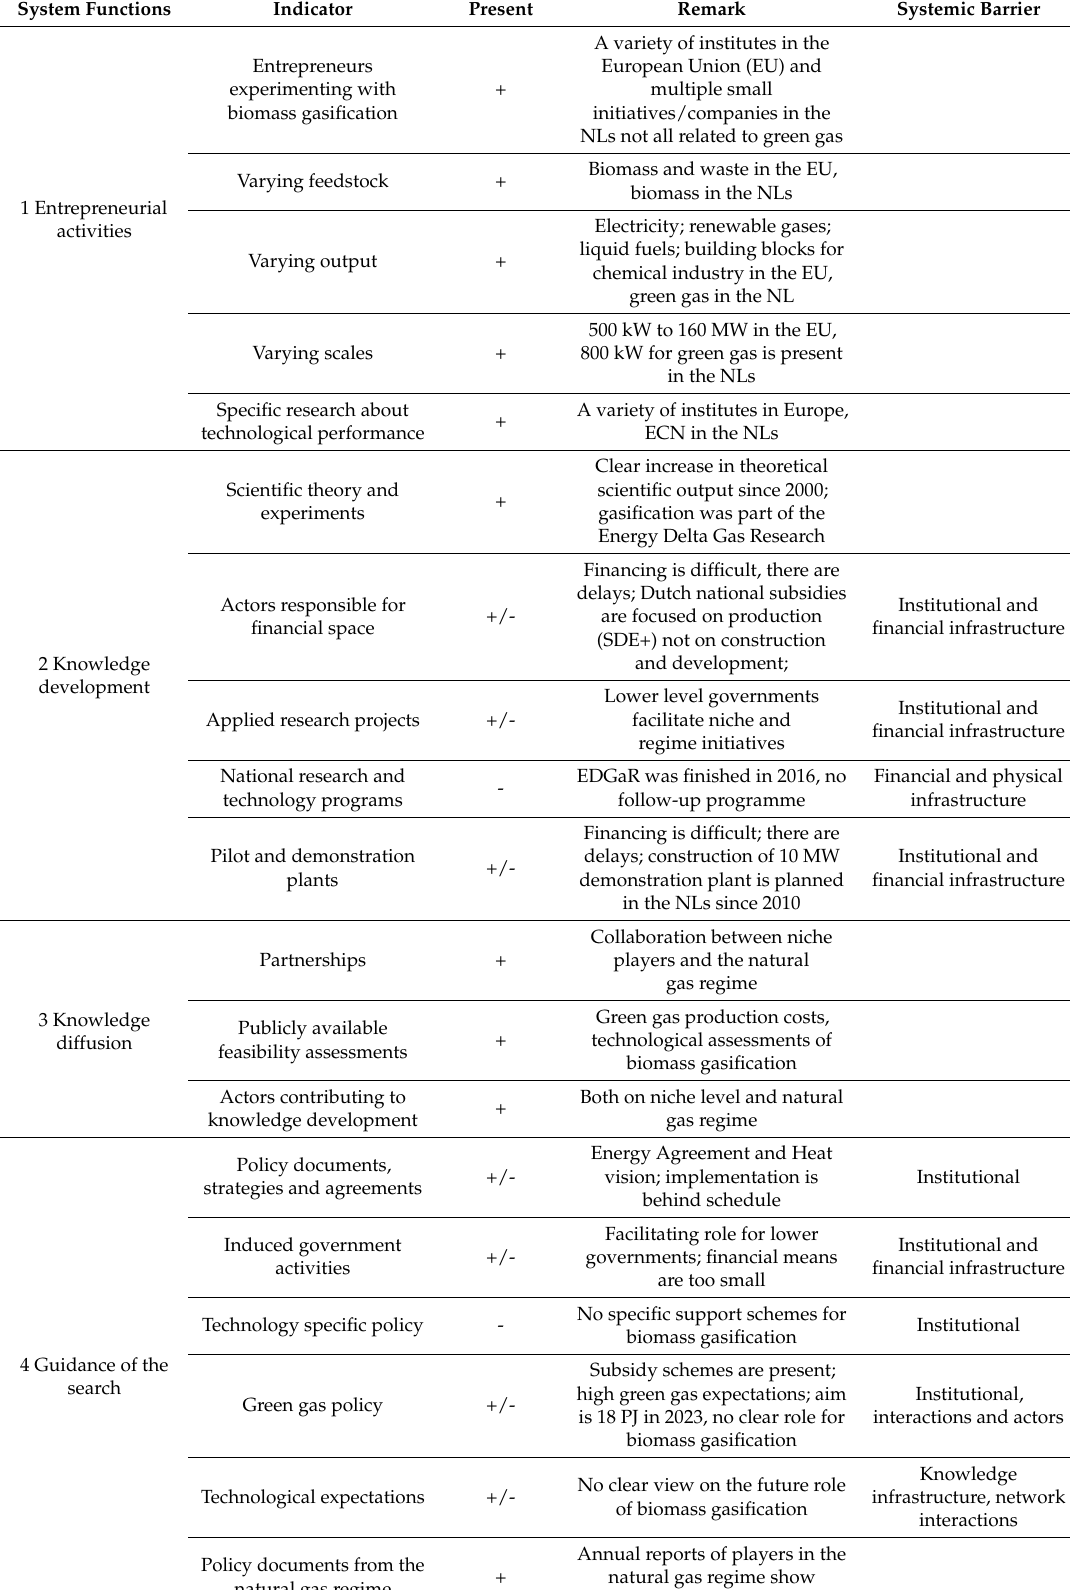
Table 2. Overview of the present (+) and absent ( − ) system functions and the systemic barriers. System